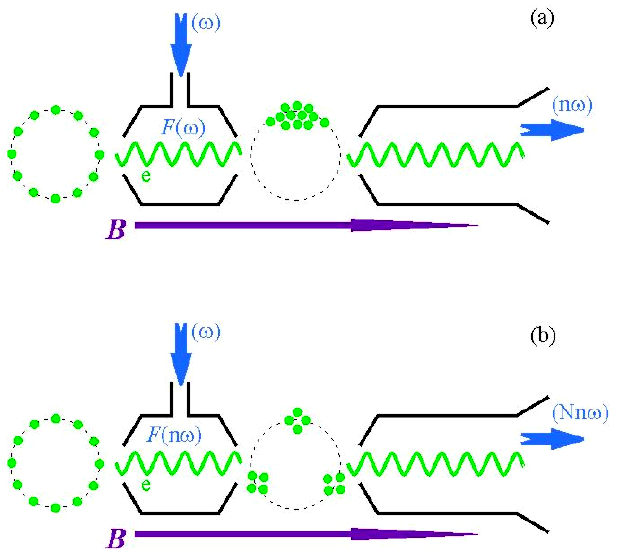
FIG. 1. (Color) Principal schematic of a CRM with frequency multiplication and electron bunching in the case of the fundamental-cyclotron-harmonic interaction in the bunching section. The cases of the electron-wave interaction inside the bunching section at the frequency of the input signal (a) and at the multiplied (namely, triple)